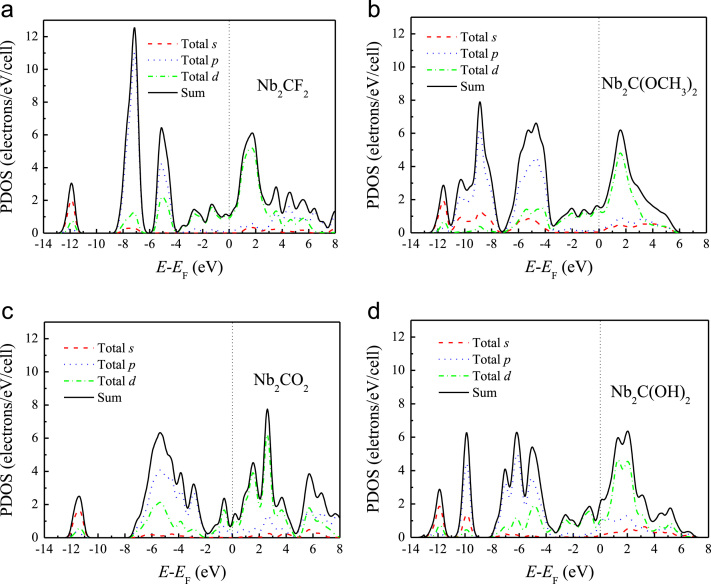
The PDOS of (a) Nb2CF2, (b) Nb2C(OCH3)2, (c) Nb2CO2 and (d) Nb2C(OH)2.